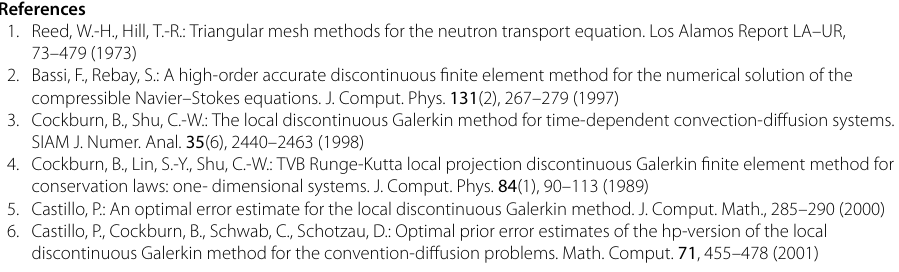
For this nonlinear equation, we still use the generalized local Lax–Friedrichs (GLLF) flux in (3.1). The time step is also taken as (cid:13) t = 5 × 10 –7 h 4 . Table 4 lists the L ∞ errors and orders for Example 3.3, from which we again observe the ( k + 1)th order of accuracy for different θ and λ when T = 0.001 and ε = 1. In addition, we also observe that the L 2 errors can reach ( k + 1 ) order for the nonlinear problem, which are omitted to save space. 2 Figure 1(b) shows the time growth with different ε , when N = 10, λ = 0.5, and θ =